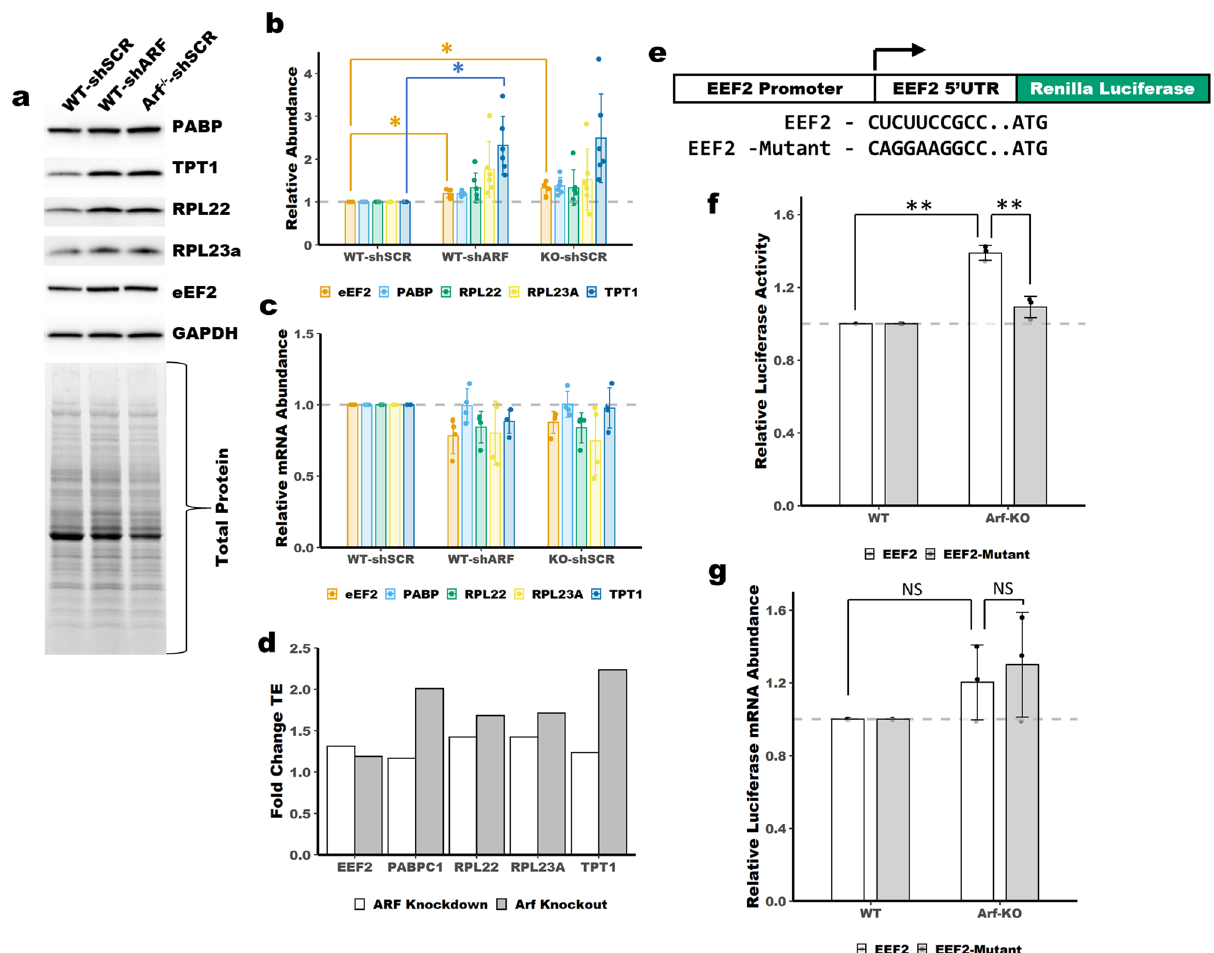
Figure 3. Upregulation of 5 ′ -TOP mRNA translation following loss of ARF. ( a ) Immunoblot analysis showing increased protein abundance of PABP, TPT1, RPL23A, EEF2 and RPL22. ( b ) Quantitation of blots in panel ( a ). Total protein was used for normalization. Mean ± SD, n = 6. ( c ) qPCR shows no change in mRNA expression of 5 ′ -TOP mRNAs. Mean ± SD, n = 4. ( d ) The average fold change of TE from two ribosome profiling replicates is shown for PABPC1, TPT1, RPL23A, EEF2 and RPL22. ( e ) Schematic of the luciferase reporters used in panels ( f , g ). ( f ) Luciferase activity of a 5 ′ -TOP reporter is increased in Arf −/− MEFs (Arf-KO). Luciferase activity was normalized to firefly luciferase transfection control and set relative to WT. Mean ± SD, n = 3. ( g ) qPCR shows no increase in mRNA expression of the 5 ′ -TOP reporter. Normalized to firefly luciferase transfection control. Mean ± SD, n = 3. *, p-value < 0.05, ** p -value < 0.01; two-tailed t-test with Bonferoni